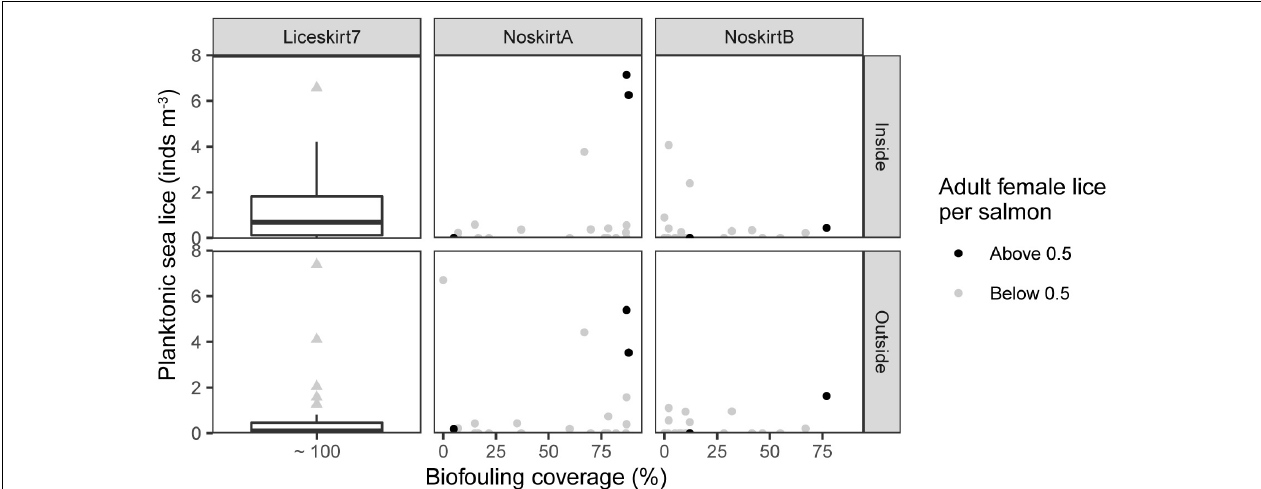
FIGURE 5 | Mean abundance of planktonic sea lice per m 3 seawater as a boxplot (Liceskirt7) or as a function of the biofouling on the cage-net (NoskirtA and NoskirtB). Results are shown for the three net pens on each of the three sites, taken inside and outside of the pen. Fill color indicates if the number of adult female lice in the sampled net pen were above or below 0.5 the same week, or the prior week. Liceskirt7: individual points categorized as outliers in the boxplot (more than 1.5 times the interquartile range from the